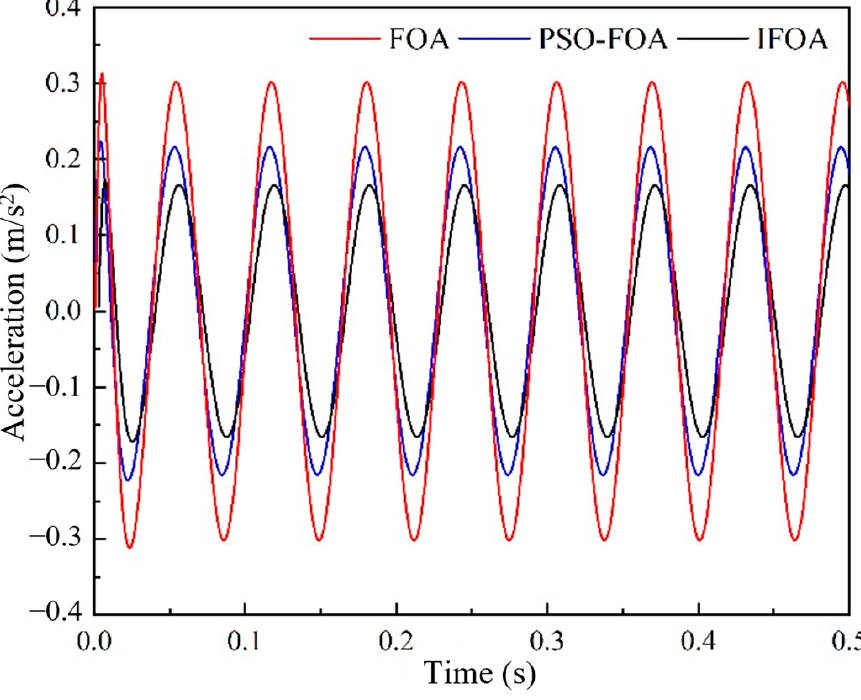
Figure 14. Vibration acceleration of vehicle body (n = 2980 r/min).